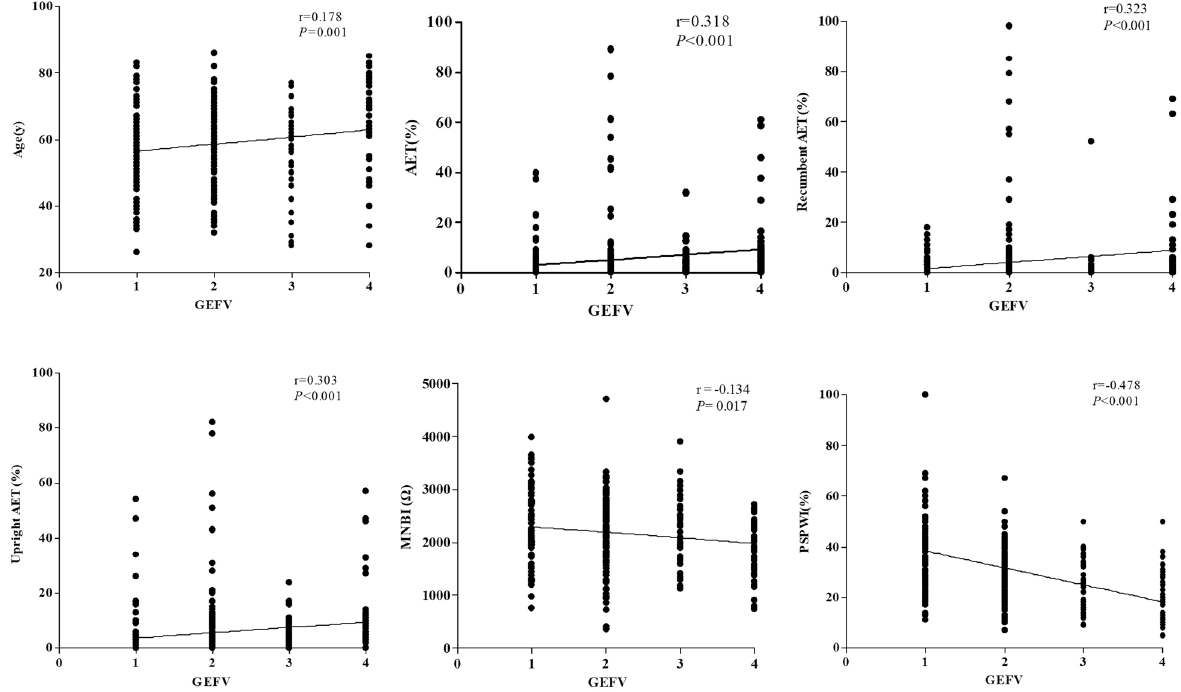
Figure 2. Associations of GEFV grade with age, total AET%, upright AET (%), recumbent AET (%), MNBI, and PSPWI. AET acid exposure time, GEFV gastroesophageal flap valve, MNBI mean nocturnal baseline impedance, PSPWI post-reflux swallow-induced peristaltic wave index.